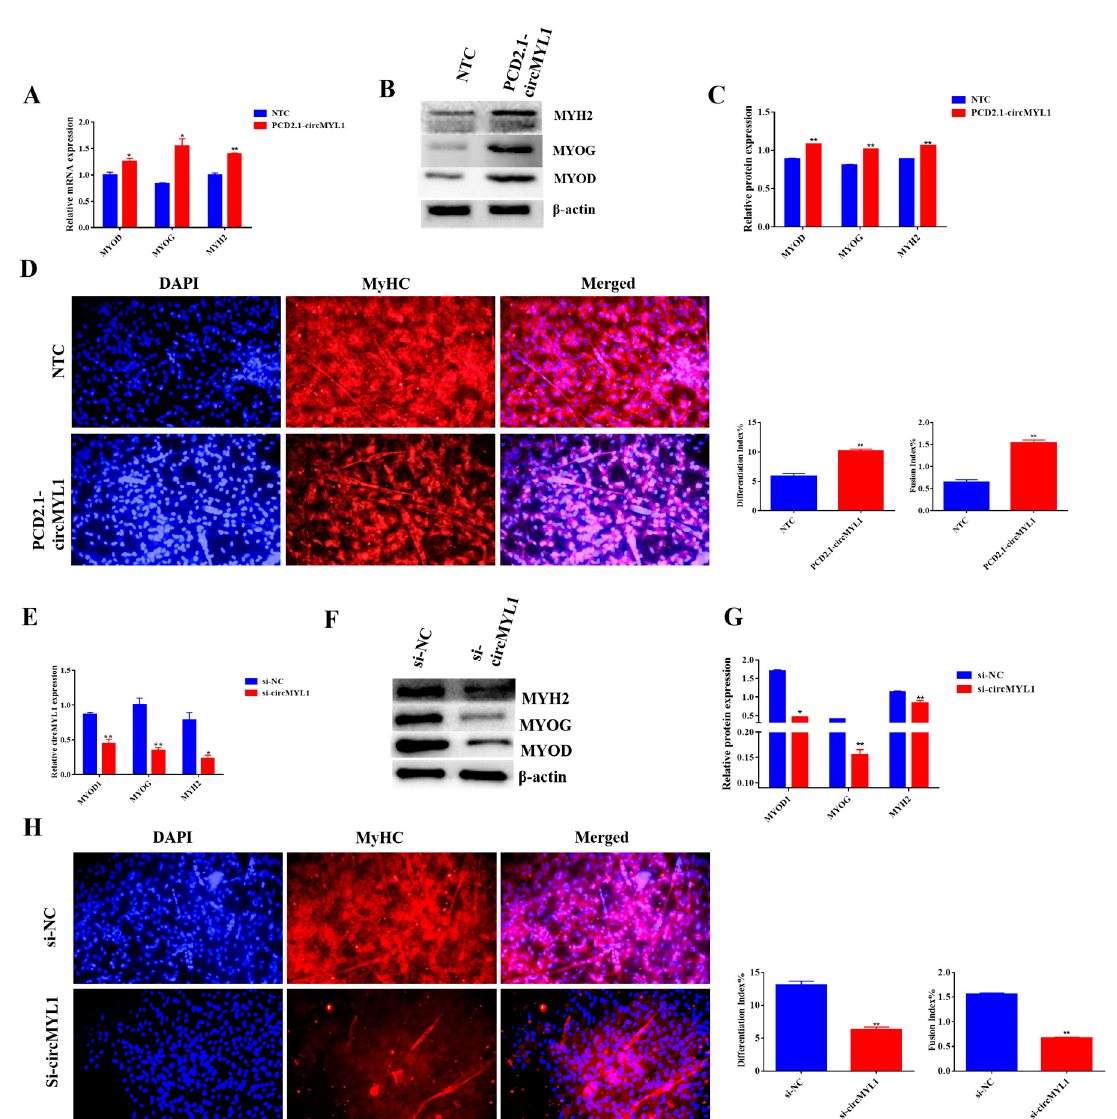
Figure 4. The effect of circMYL1 on the differentiation of myoblasts. The bovine primary myoblasts were transfected by pCD2.1-circMYL1/NTC or si-circMYL1/si-NC and differentiated cells for four days. Then, the cells were harvested. ( A ) qRT-PCR detected the relative expression levels of differentiation marker genes MyoD , MyoG , and MYH2 after transfection with the circMYL1 overexpression vector. ( B ) Western blot detected the protein expression levels of differentiation marker genes MyoD , MyoG , and MYH2 . ( C ) Histogram graph showing the protein band density evaluated using ImageJ. ( D ) Immunofluorescence detected MyHC (red)-positive myotubes after transfected by the circMYL1 overexpression vector, and the differentiation index and fusion index were counted. ( E ) qRT-PCR detected the relative expression levels of differentiation marker genes MyoD , MyoG , and MYH2 after transfected with si-circMYL1. ( F ) Western blot detected the protein expression levels of differentiation marker genes MyoD , MyoG , and MYH2 . ( G ) Histogram graph showing the protein band density evaluated using ImageJ. ( H ) Immunofluorescence detected MyHC (red)-positive myotubes after transfection by si-circMYL1. And they were detected under a fluorescence microscope: scale bar, 200 µ m, and the differentiation index and fusion index were counted. Data are shown as mean ± SEM. n = 3. * p < 0.05; ** p <